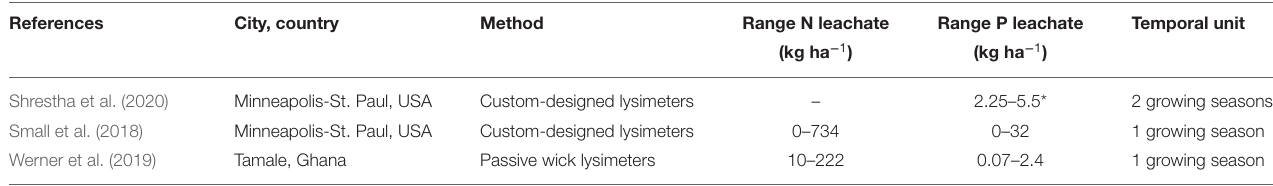
TABLE 3 | Ranges of nitrogen (N) and phosphorus (P) leachate found in studies that had an experimental design to quantify leachate under different management conditions.